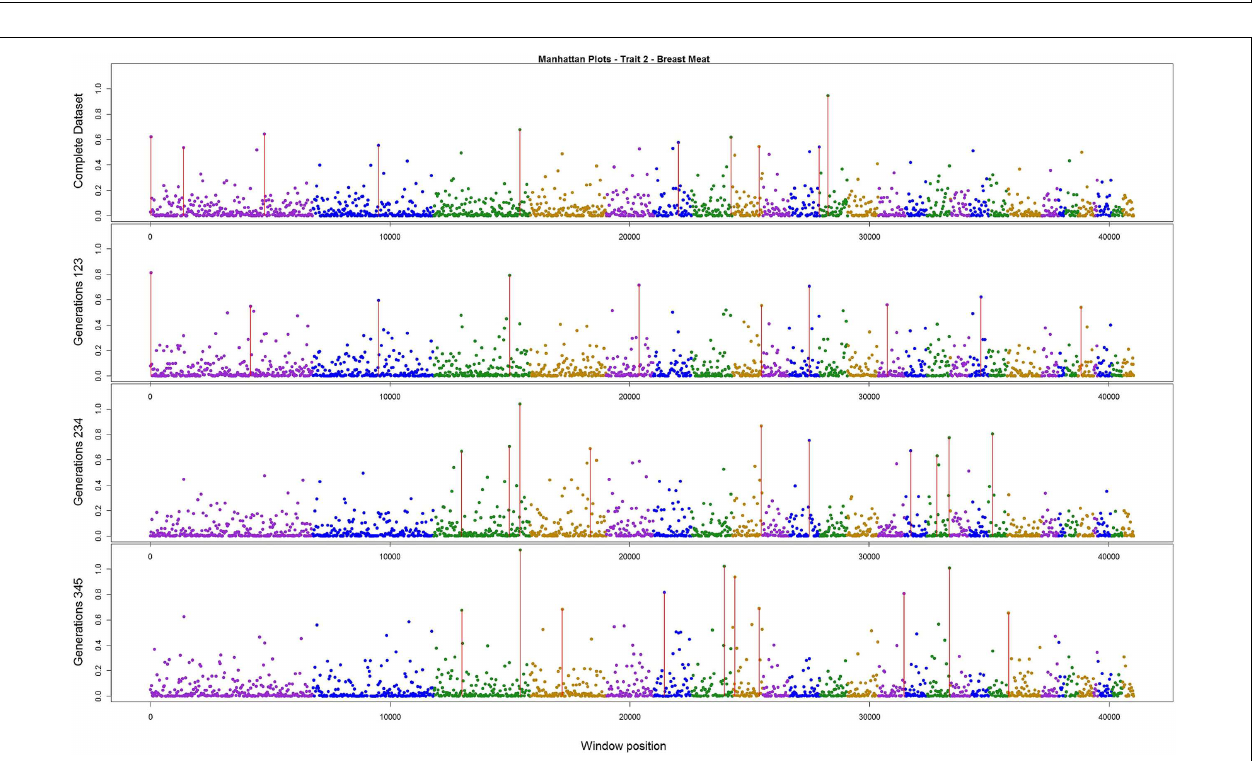
FIGURE 3 | Manhattan plots for percentage of variance explained for Breast meat, performed for all the data set, and the subsets of generations.